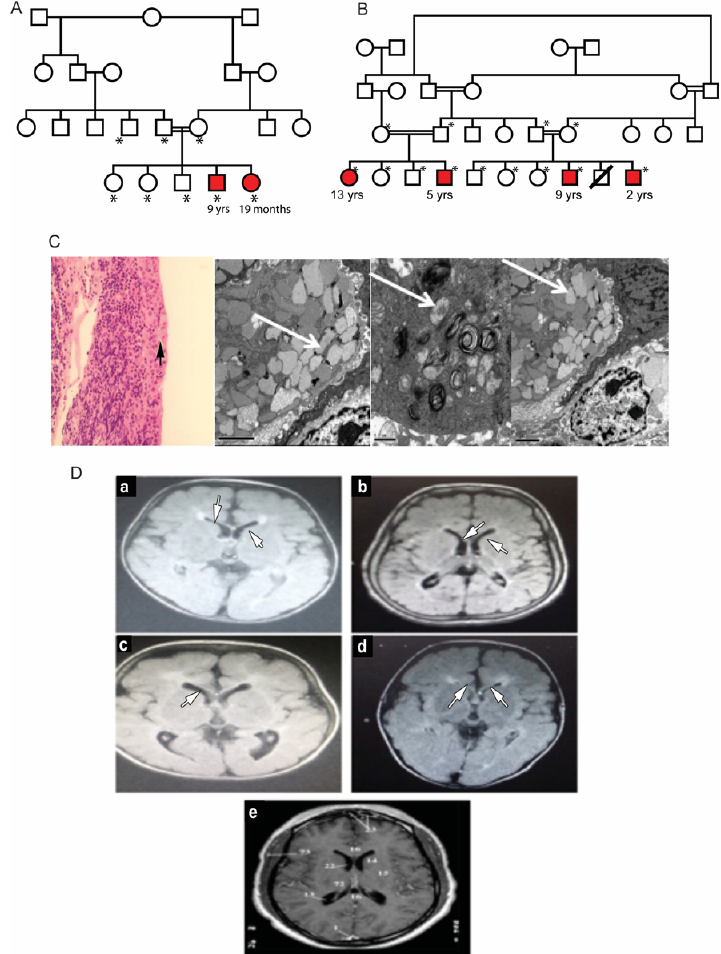
Figure 1. Clinical features of patients with mucolipidosis type IV. ( A , B ): Family pedigrees of two MLIV families. Affected siblings are highlighted in red color. *: individuals with an available DNA sample for molecular testing. ( C ): Conjunctival biopsy histological results. Left: H and E staining showing mild engorgement of goblet cells with secretions (black arrow). Right: Intra-cytoplasmic inclusion bodies in conjunctival tissue of MLIV patients. The bodies are multiple cytoplasmic single membranes with limited vacuoles (marked with white arrows). ( D ): Brain MRI findings in the studied MLIV patients. ( a ): Brain of the 9-year-old affected male of Family 1. ( b – d ): Patients of Family 2 aged 13, 5 and 9 years old, respectively. MRI images show hypomyelination and thinning of the corpus callosum (indicated by white arrows) with midline cerebellar atrophy. ( e ): A normal MRI of a 6-year-old brain for comparison. Table 1. Clinical features of patients with mucolipidosis type IV in this study.